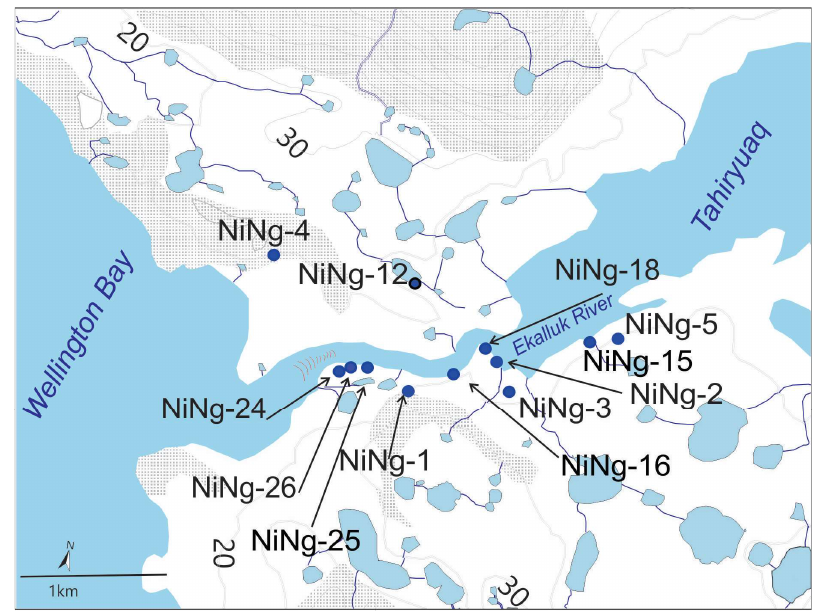
Figure 6. Middle Dorset (2000–1600 cal B.P) site location situated on proposed paleogeography at approximately 2050 cal. B.P. Marine limit would have been at the modern 10 m contour.